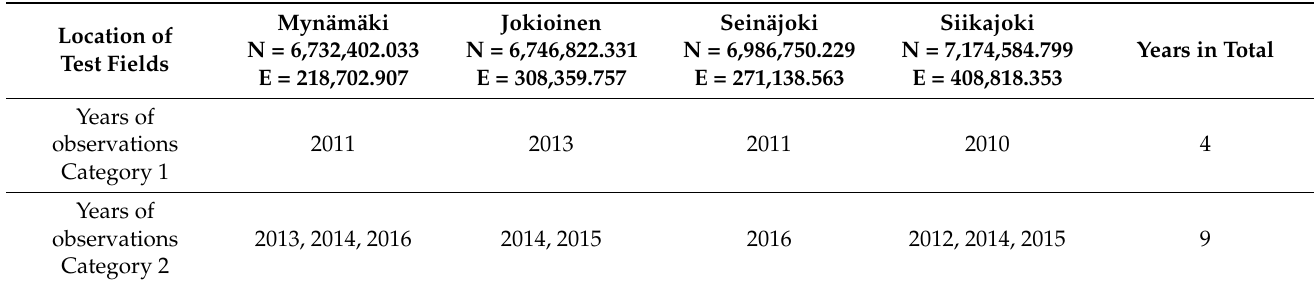
Table 1. Location of test fields and the years of utilised weather data by category.